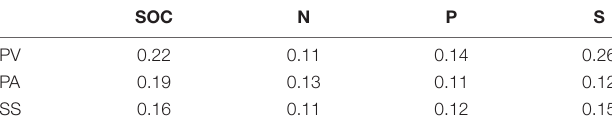
TABLE 1 | Topsoil concentration factors of C, N, P, and S in PV, PA, and SS wetlands. SOC N P